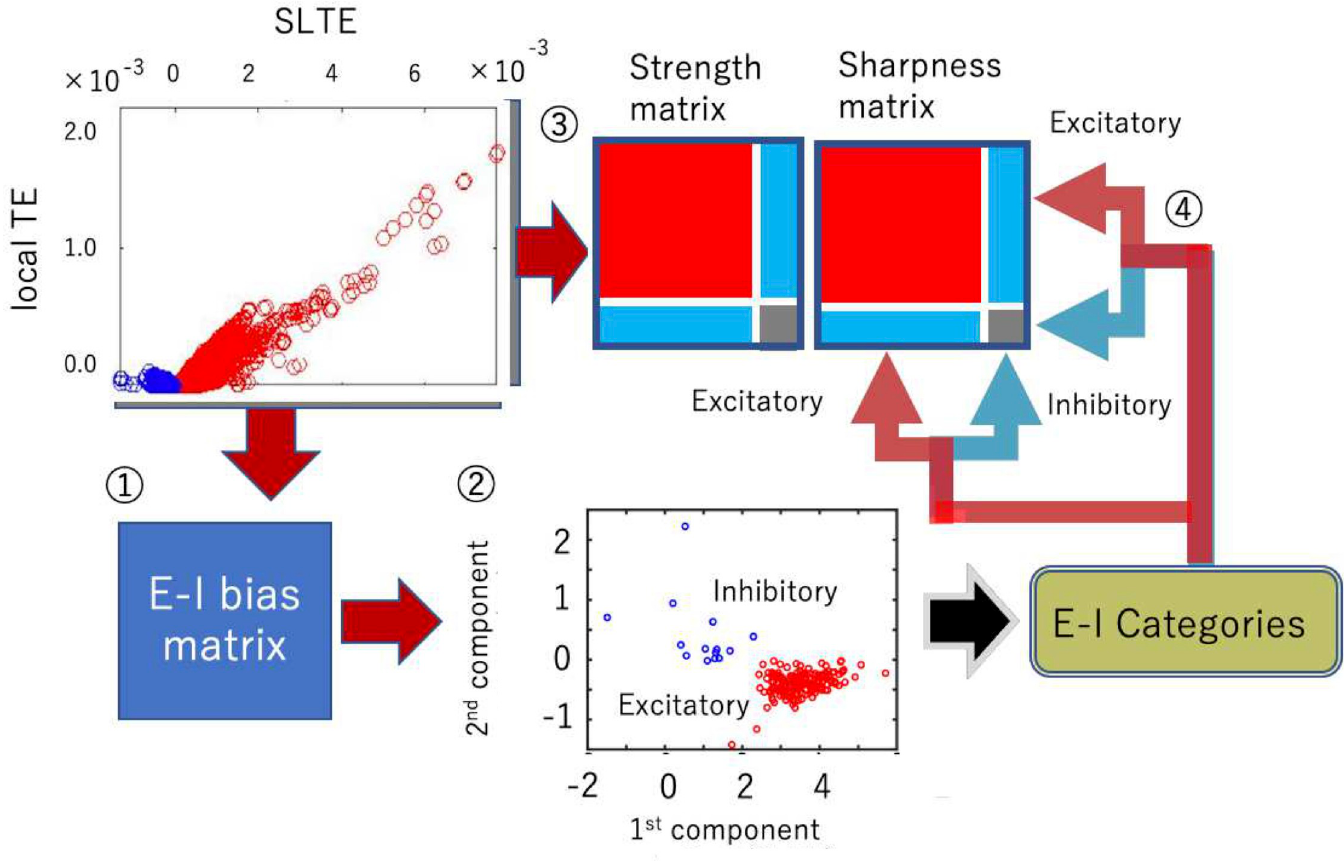
Fig 3. Four processing steps as a combination of cell categorization and connectivity estimation: ① First, we calculated E-I bias (SLTE at the delay where TE shows the peak value). ② Then, we determined the sign, positive or negative by observing the clustered distributions in the two-dimensional space of the the 1st component ( / ∑ connections in top 90% about peakTE SLTE ) and the 2nd SLTEs components ( / log 10 FR ). ③ We calculated Strength and Sharpness from the TE ( d ), Transfer Entropy as a function of delay d, according to the analysis scheme shown in Fig 2C and 2D. ③ Finally, we separated the Strength and Sharpness matrices into excitatory and inhibitory groups based on the classification of step ② . (b) The cell categorization preceded the connectivity determination because we should prepare the shuffled null data separately for excitatory and inhibitory synaptic connections to determine connected neuron pairs [Refer to the supplemental material of Shimono, Beggs, 2014 for more detailed information]. We separately produced the connectivity matrix for excitatory and inhibitory neurons by selecting strong or sharp connections as compared with the null shuffled data.